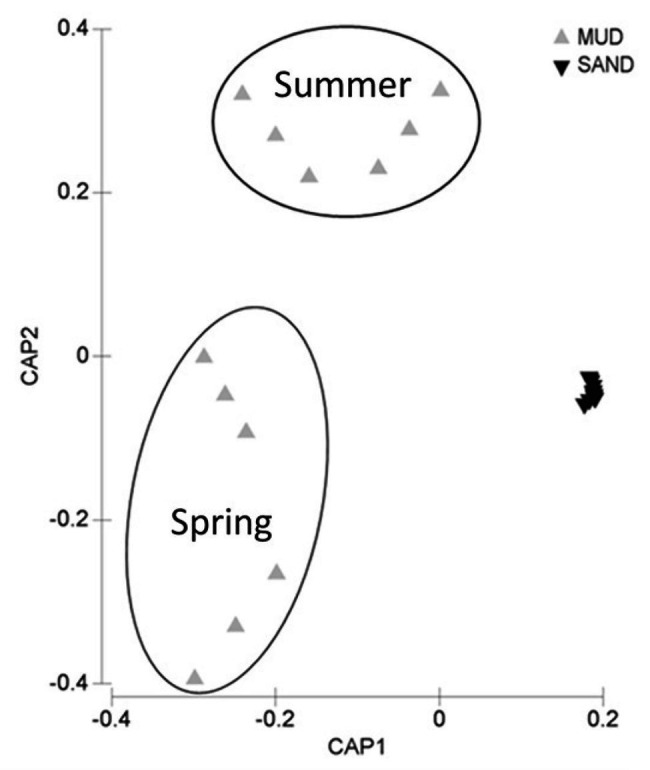
Bi-plot after the canonical analysis of principal coordinates (CAP) illustrating differences in the biochemical composition of sedimentary organic matter in the two sediment types.